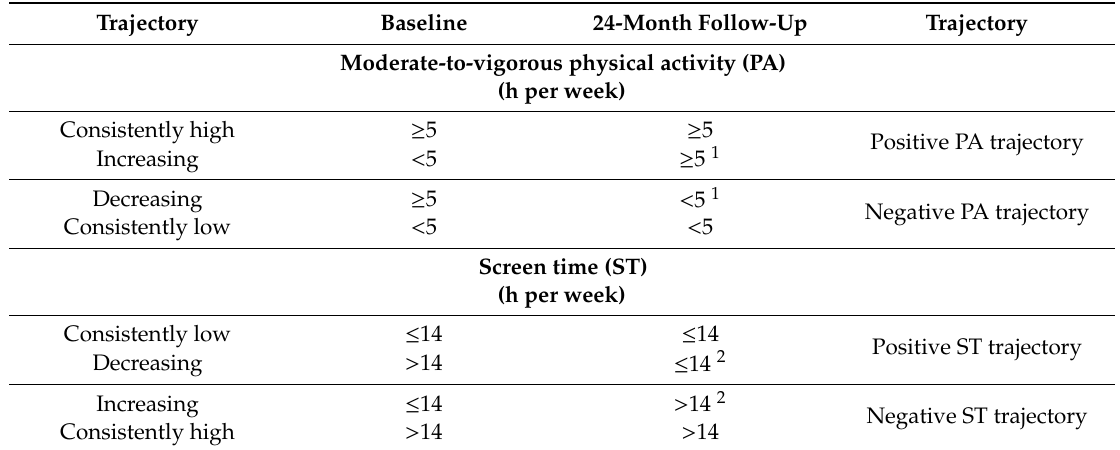
Table 1. Definition of physical activity and screen time